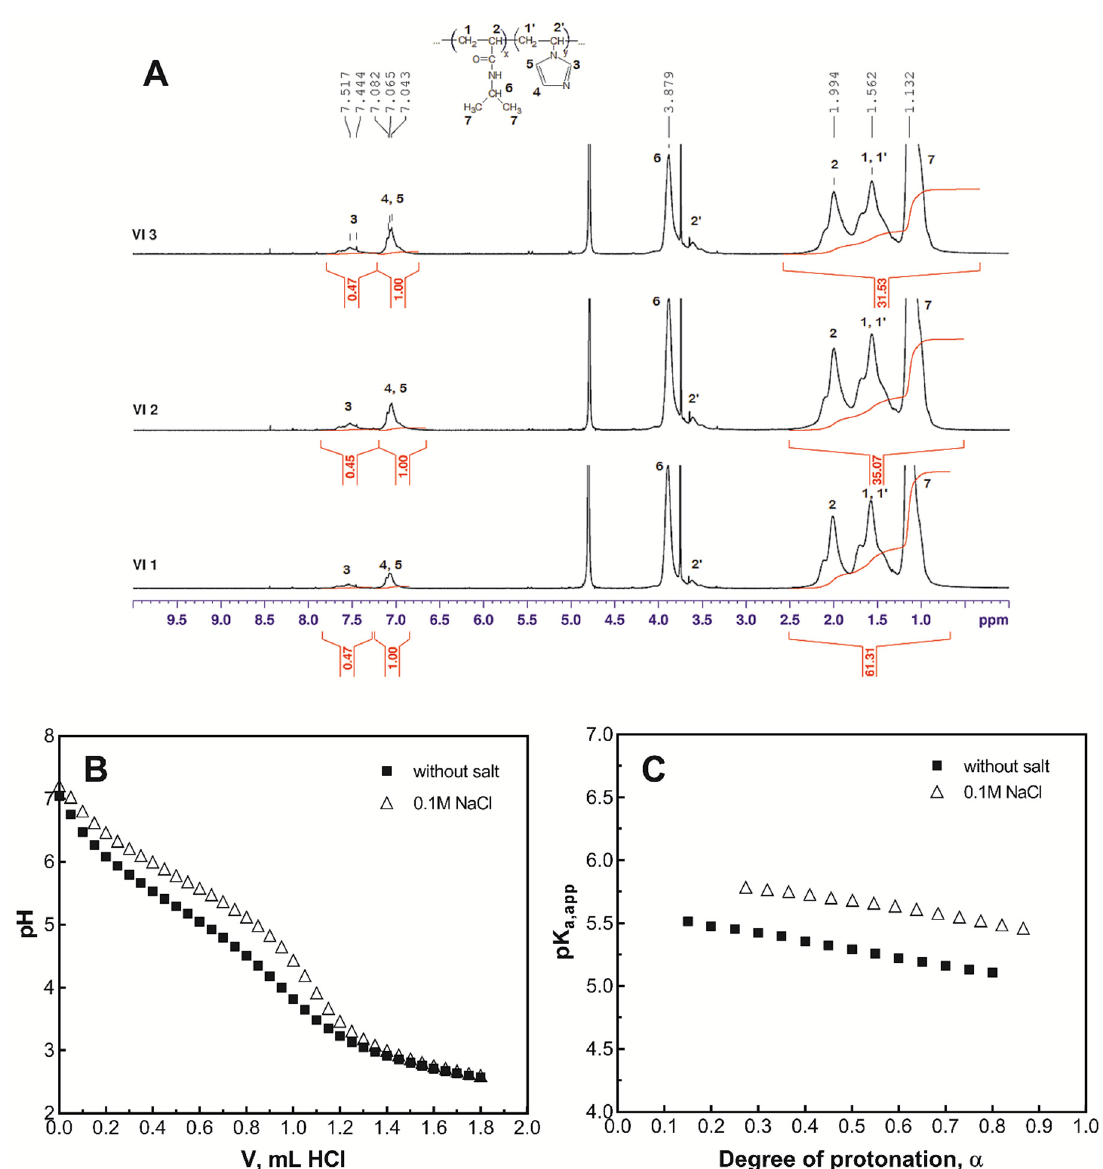
Figure 1. Characterization of poly(NIPAAm-co-VI) copolymers: 1 H-NMR spectra in D 2 O ( A ); potentiometric titration curves of polymer aqueous solution (sample VI 2 in Table 1) in the absence (empty symbols) and in the presence (filled symbols) of 0.1 M NaCl ( B ); dependence of p K a,app on the dissociation degree α ( C ).